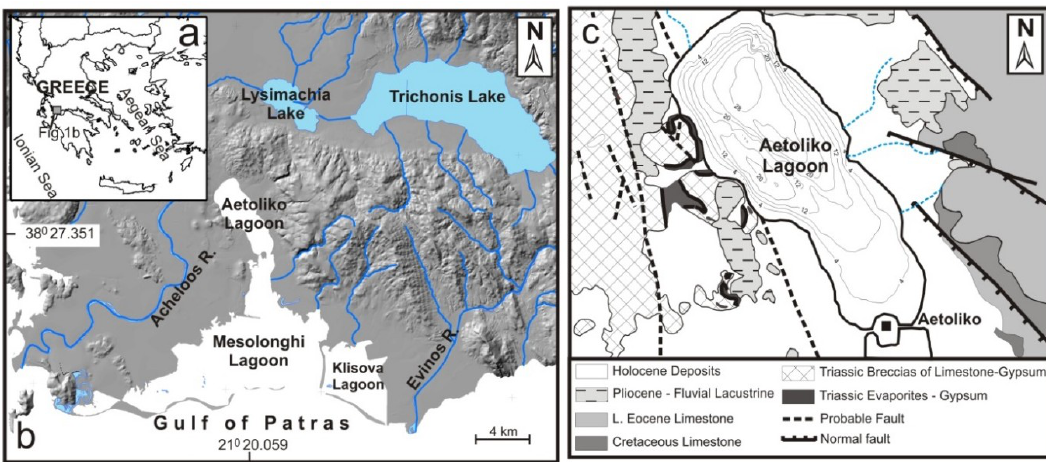
Figure 1. ( a ) General map of Greece and the location of the Aetoliko lagoon; ( b ) topographic map of the surrounding area of Aetoliko lagoon and the wetlands of Mesolonghi, Aetoliko, and Klisova lagoons complex; and ( c ) simplified geological map of the studied area.